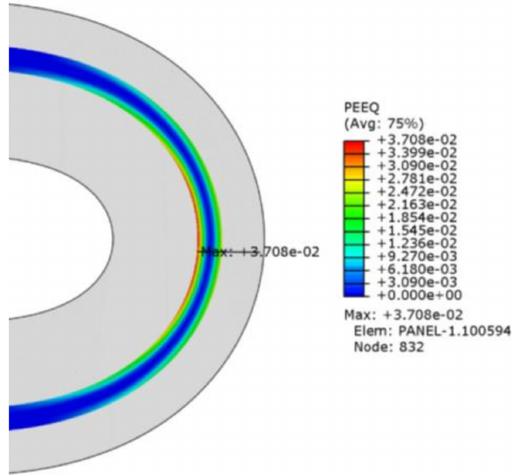
Figure 6. Distribution of equivalent plastic strain after bending with R = 1